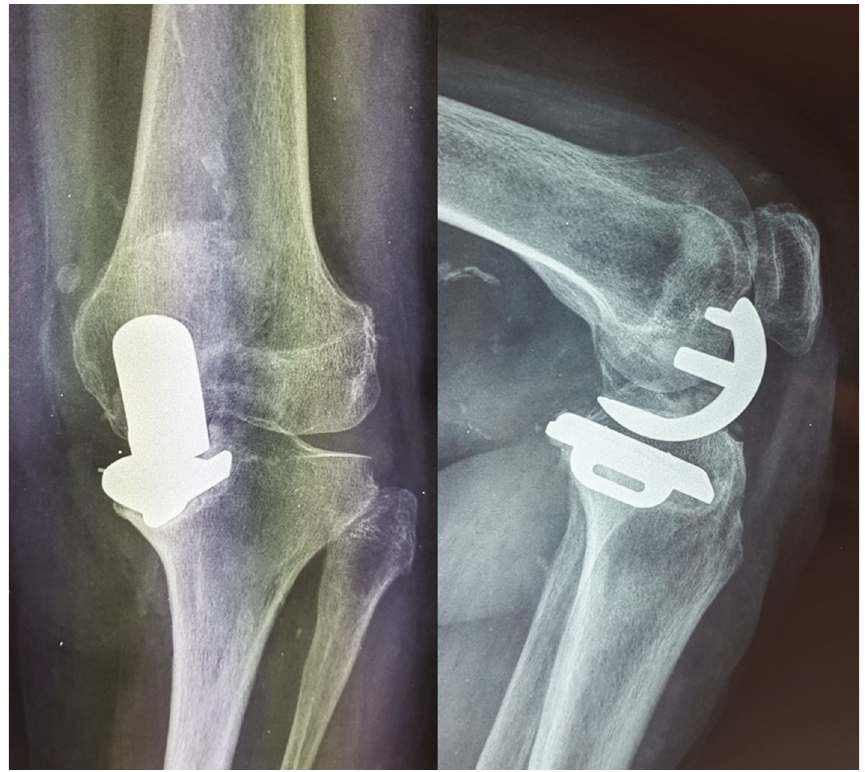
Figure 1: Anteroposterior and lateral X-ray views during initial evaluation. Mal-positioning of the unicompartmental knee arthroplasty with varus deformity is